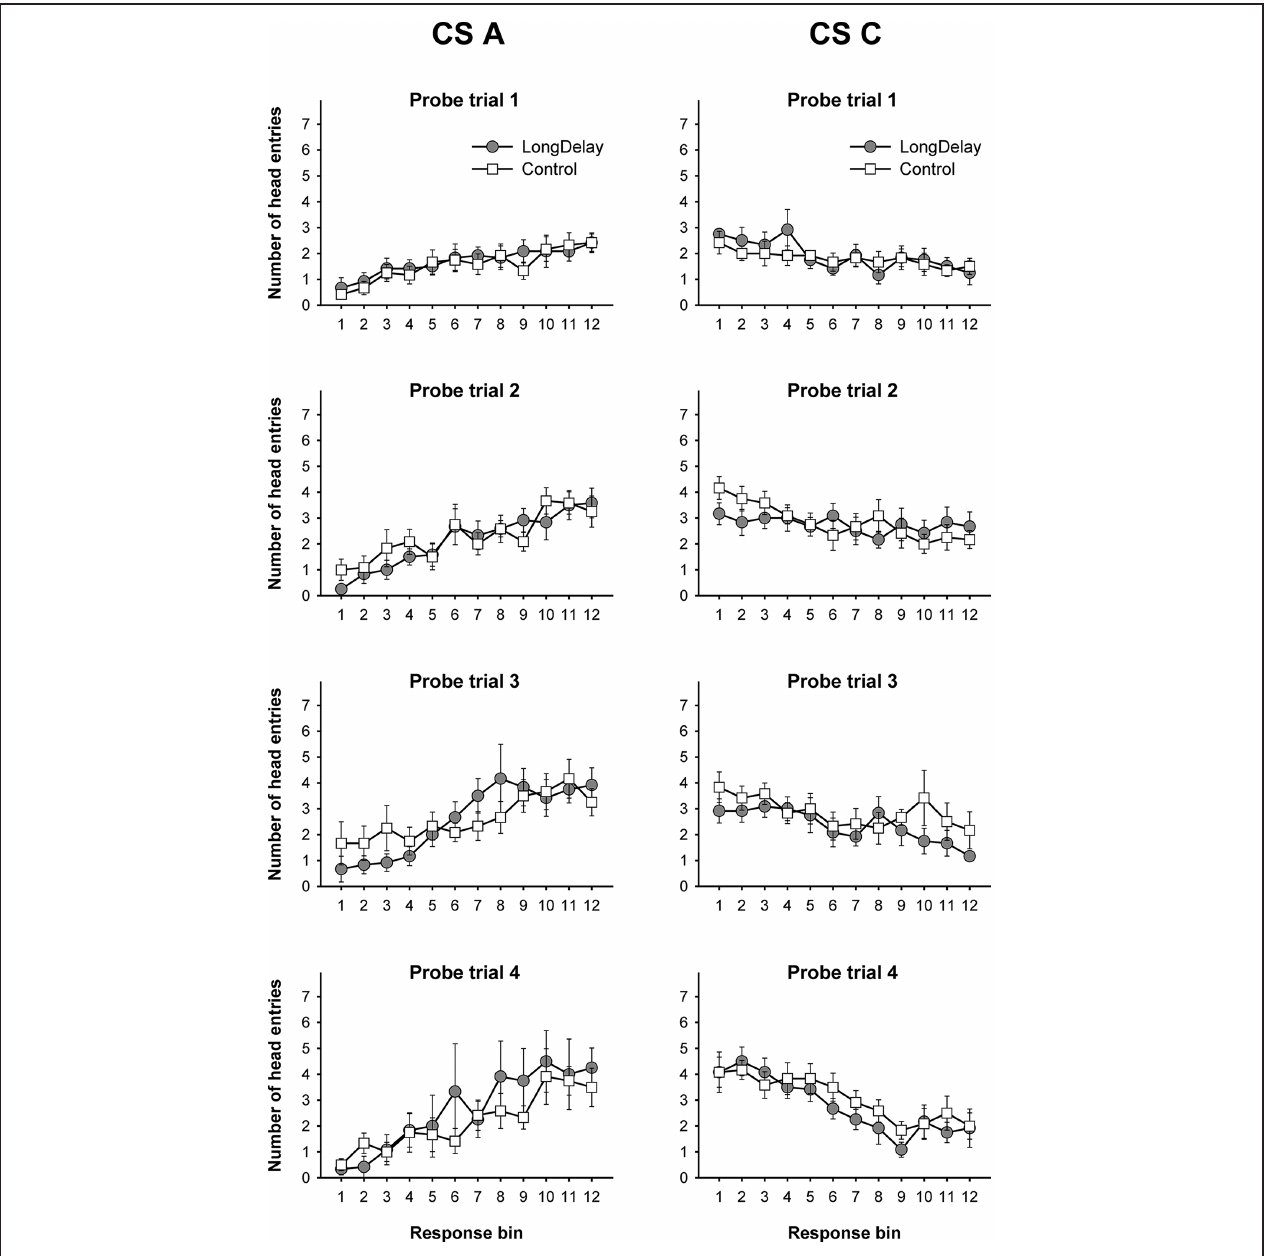
FIGURE 2 | Long delay conditioning, Experiment 1a. Responding to CS A (left) and CS C (right) during each of the 12 5-s bins of the first four probe trials of long delay conditioning training. US delivery was expected at 55 s (Bin 11) or 10 s (Bin 2) after onset of CSs A and C, respectively. Probe trials for CS A occurred every 90th trial, whereas for CS C they occurred every 10th trial. Brackets represent the standard error of the